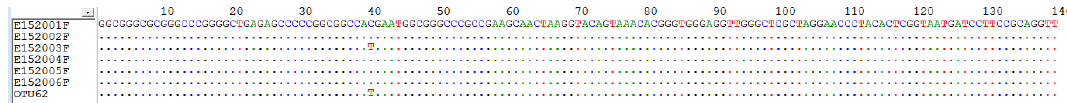
Figure 2. Alignment (using Bioedit v7.2.6.1) of partial ITS1 region of the ribosomal cluster of the six strains of A. flavus , against OTU62.